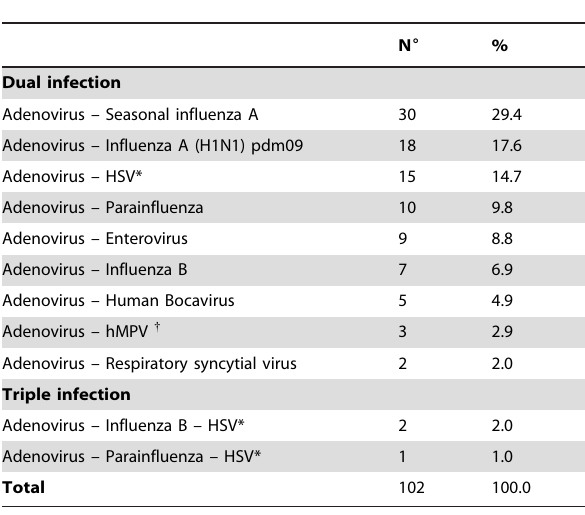
Table 2. Distribution of